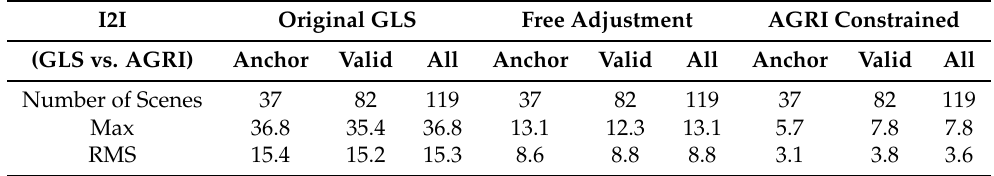
Table 4. Summary statistics from the I2I characterization for the anchor and independent validation